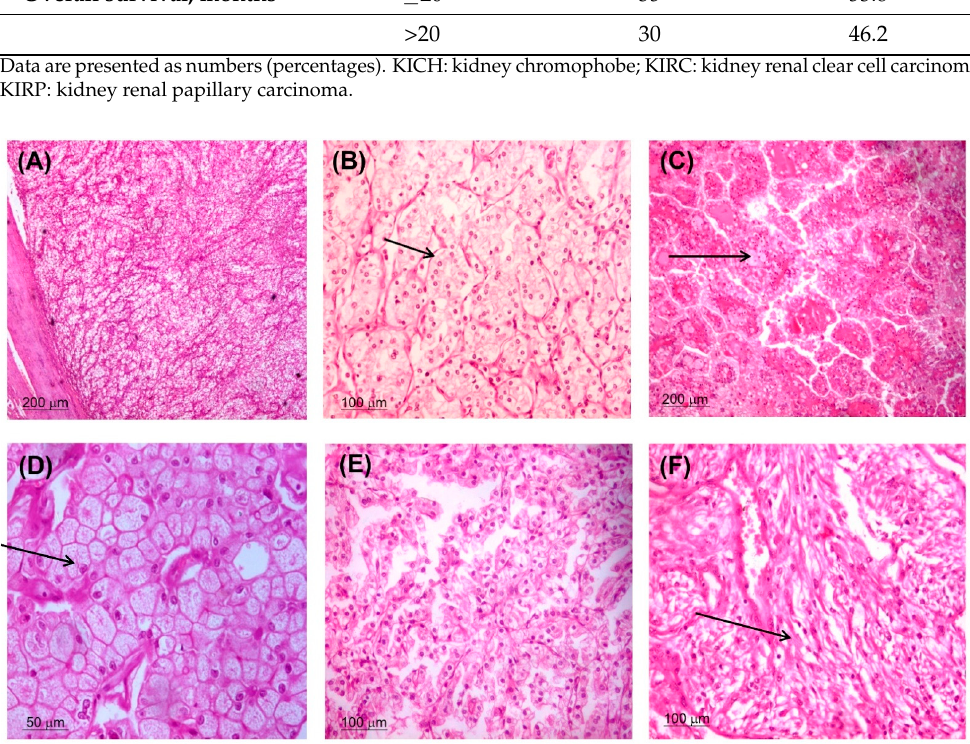
Figure 1. Morphological types of RCC. Clear cell type (( A ) × 100 and ( B ) × 200) with clear cytoplasm, well defined cell borders, and nuclear grade 2 (black arrow). Papillary RCC (( C ) × 100) showed papillary structures with core containing foam cells (black arrow) and covered by columnar cells. Chromophobe RCC (( D ) ×400) formed of nests of cells with abundant eosinophilic cytoplasm and raisin nuclei (black arrow). RCC with variable features suspected to be unclassified type that need genetic study (( E ) ×200). RCC with sarcomatoid features (black arrow) and considered grade 4 (( F ) ×200). Table 1. Clinicopathological characteristics of renal cell carcinoma patients ( n = 65).